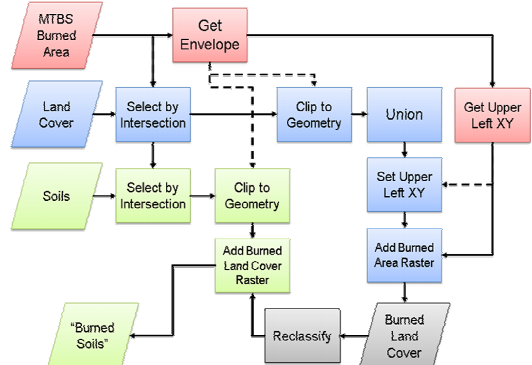
Figure 6. Example geo-processing workflow for the soils